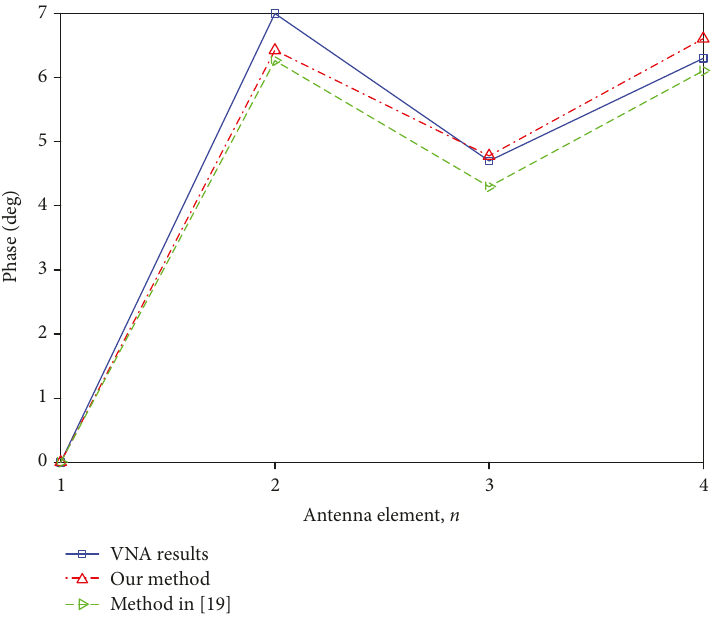
Figure 13: The phase calibration results of the four-element patch antenna